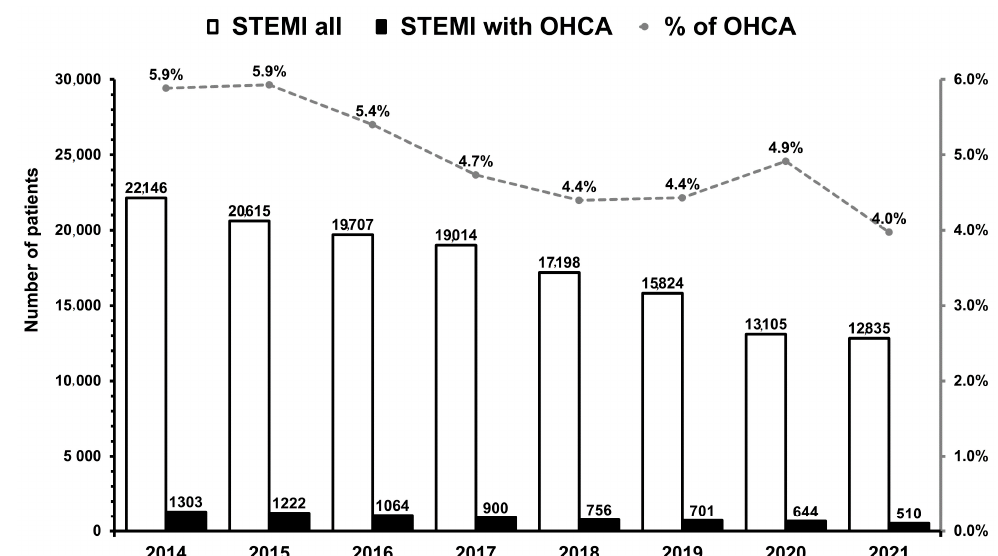
Figure 2. The total number of patients with STEMI and STEMI complicated by OHCA between 2014 and 2021 ( p = 0.001). The dotted line represents the proportion of STEMI with OHCA to STEMI in each year.; STEMI—ST-segment-elevation myocardial, OHCA—out-of-hospital cardiac arrest.